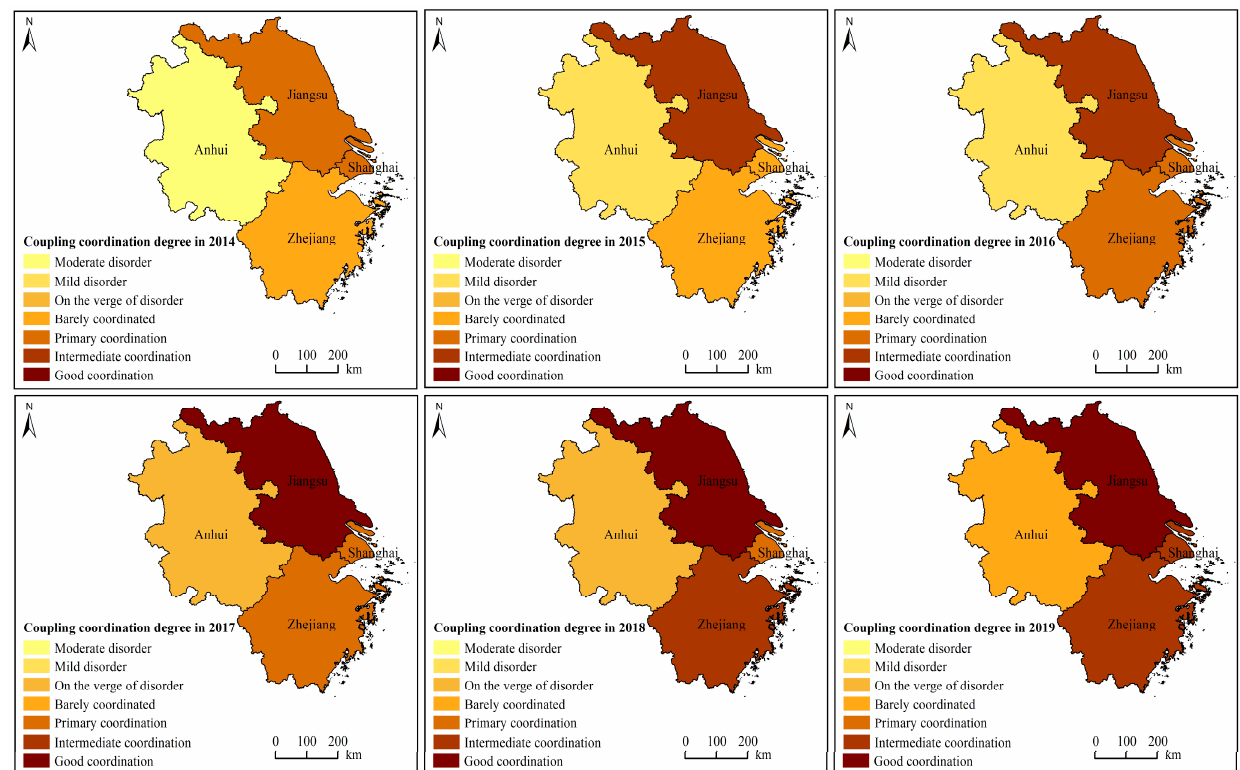
Figure 6. Evolution trends of coupling coordination degree of the innovation EROB composite system in the YRD region.